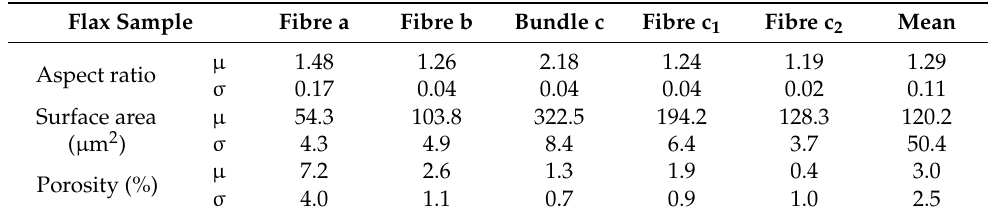
Table 2. Aspect ratio, surface area and porosity content of two flax fibres “a” and “b” and a bundle “c” composed of two fibres “c1” and “c2” obtained from µ -CT data, with µ the mean value and σ the standard deviation. Last column represents the mean values of the fibres “a”, “b”, “c1” and “c2”.